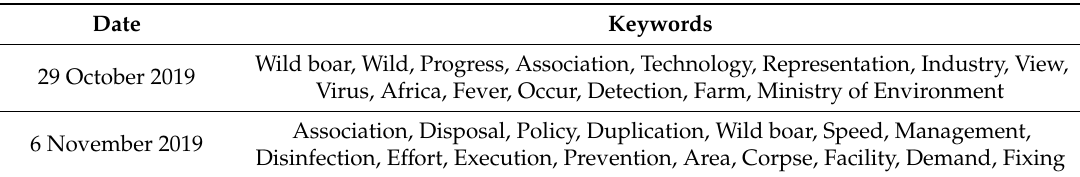
Table 1. The result of topic modeling on news